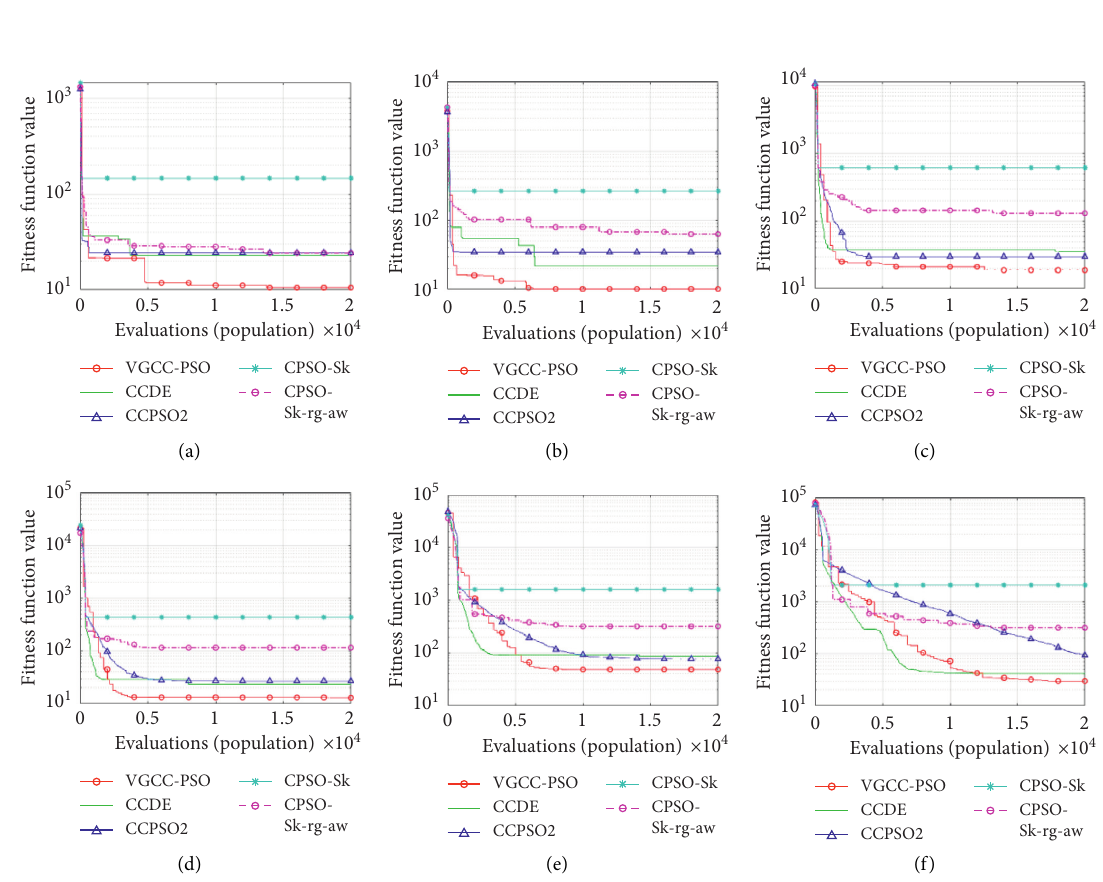
Figure 6: Convergence graphs for Case 1 to 6: (a) Case 1; (b) Case 2; (c) Case 3; (d) Case 4; (e) Case 5; (f) Case